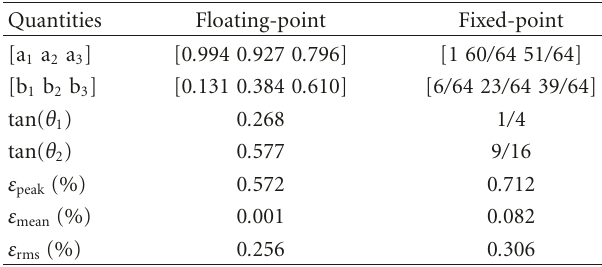
Table 1: Amplitude approximation over three angular intervals: amplitude approximation coe ffi cients and resulting relative ampli- tude errors for floating-point and fixed-point implementations.